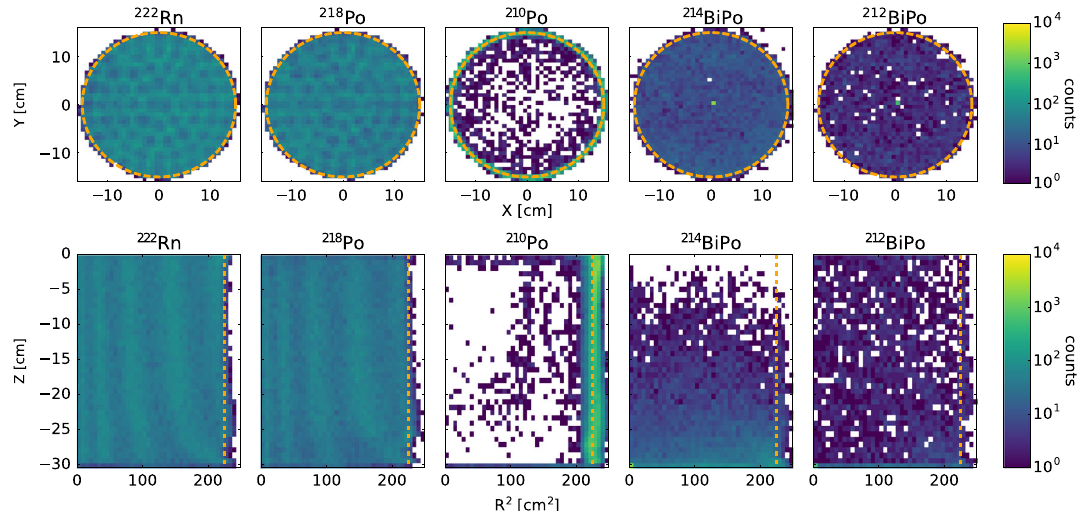
Fig. 4 Spatial distributions of the radon populations identified in XENON100. Dashed lines indicate the TPC’s radius. For 222 Rn and 218 Po, the main S2 signal is required to be larger than 80000PE to sep- arate both from 210 Po at R > 135mm (losses introduced by this cut are negligible at smaller radii). (Top) XY distributions. Due to vertex reconstruction artifacts caused by PMT saturation, the structure of the top PMT array is visible in the 222 Rn and 218 Po data. (Bottom) R 2 Z